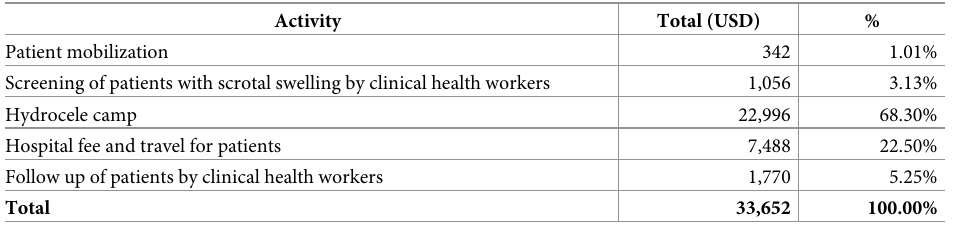
Table 5. Cost Breakdown by Major Activity. Activity Screening of patients with scrotal swelling by clinical health